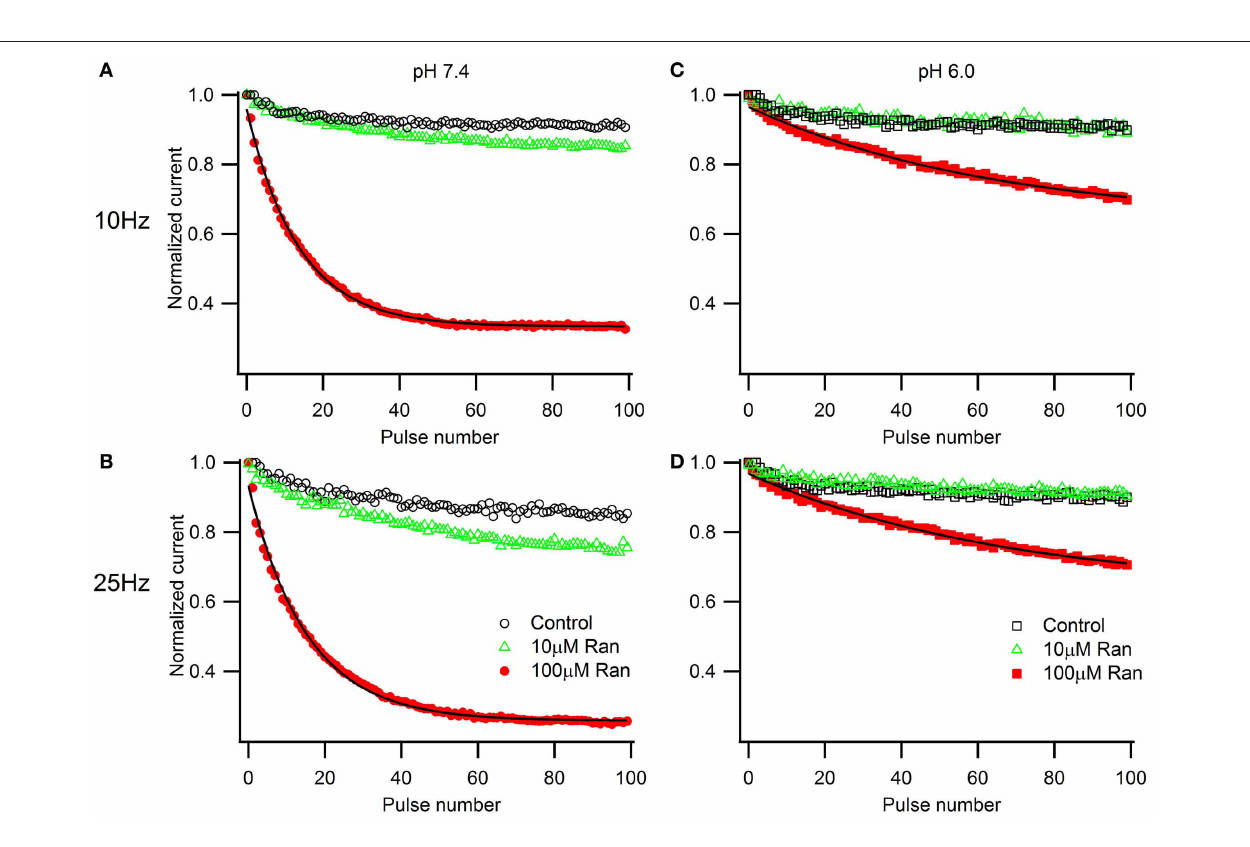
FIGURE 4 | Use-dependent inactivation induced by one hundred 5ms pulses to − 10mV applied at 10Hz (A,C) or 25Hz (B,D) from holding potential − 100mV at extracellular pH 7.4 (A,B) and 6.0 (C,D). Error bars